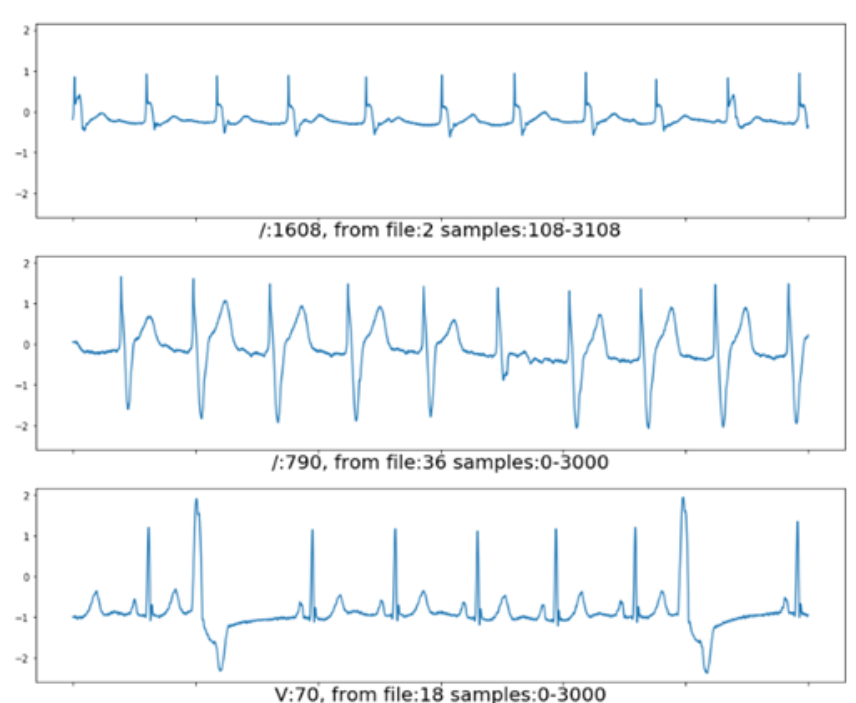
Figure 1. The ECG chunk contains 3000 samples from 3 files, i.e., the 2nd, 18th, and 36th files. The vertical axis is the voltage in mV, while the horizontal axis is time with a scale of 500 samples or 1388 s. The text on the horizontal axis contains the type of beat, and its R-peak position, for example, /: 1608, means that the beat is Paced Beat (see Table 1) with R-peak position at the 1608th sample from 650,000 samples in the 2nd file.